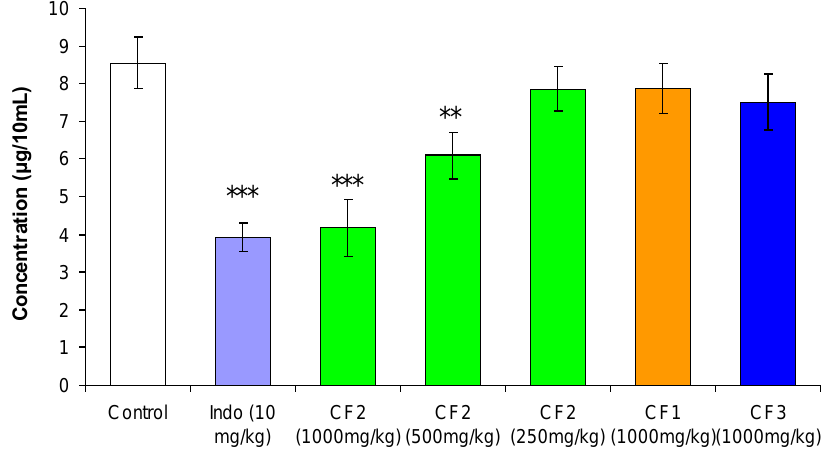
Figure 3. Effects of Orthosiphon stamineus leaf chloroform extract fractions on peritoneal capillary permeability (n =